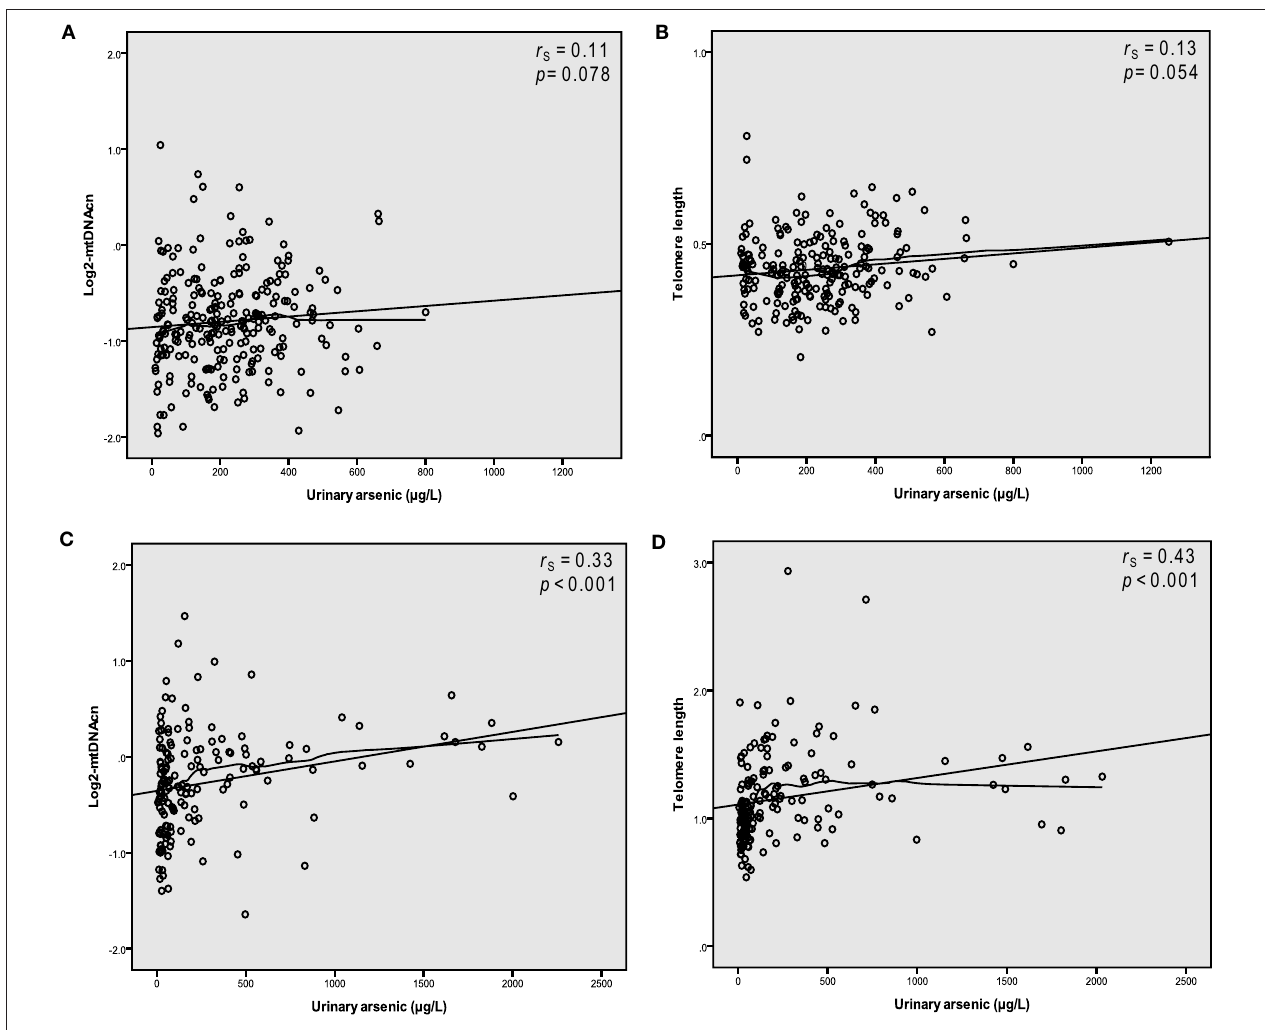
FIGURE 1 | Arsenic in urine is associated with higher copy number of mitochondrial DNA (log2-transformed, abbreviation mtDNAcn) and longer telomeres in blood. Scatter plots depicting relations between urinary arsenic (sum of inorganic arsenic metabolites) concentrations and log2-mtDNAcn and telomere length in Andes (A,B) and Chaco (C,D) .